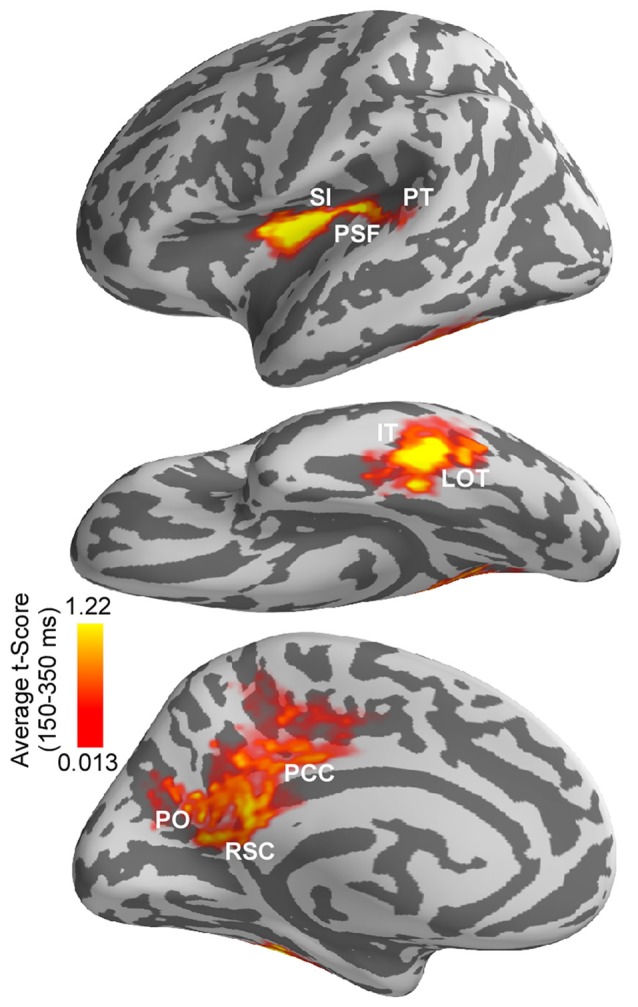
Differences in estimated cortical activity following the onset of saccades vs. saccade-like external image movement. Differences were evaluated using cluster-based analysis across whole cortex and response time. Significant spatiotemporal clusters (corrected p < 0.05) with time-courses between 150–350 ms emerged in a left-lateralized cortical network. This network overlapped with anatomically defined: (i) left lateral occipitotemporal (LOT) and nearby inferotemporal (IT) cortex; (ii) left posterior Sylvian fissure (PSF), superior insula (SI) and nearby planum temporale (PT); and (iii) medial parietooccipital (PO), posterior cingulate (PCC) and retrosplenial cortex (RSC). Average t-score values over 150–350 ms response-window are illustrated for significant clusters only. Average t-score values are indicated with color bars.